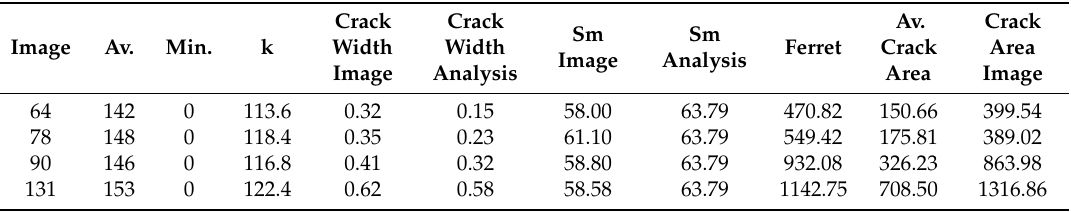
Table 1. Measured and calculated results for Specimen 1.